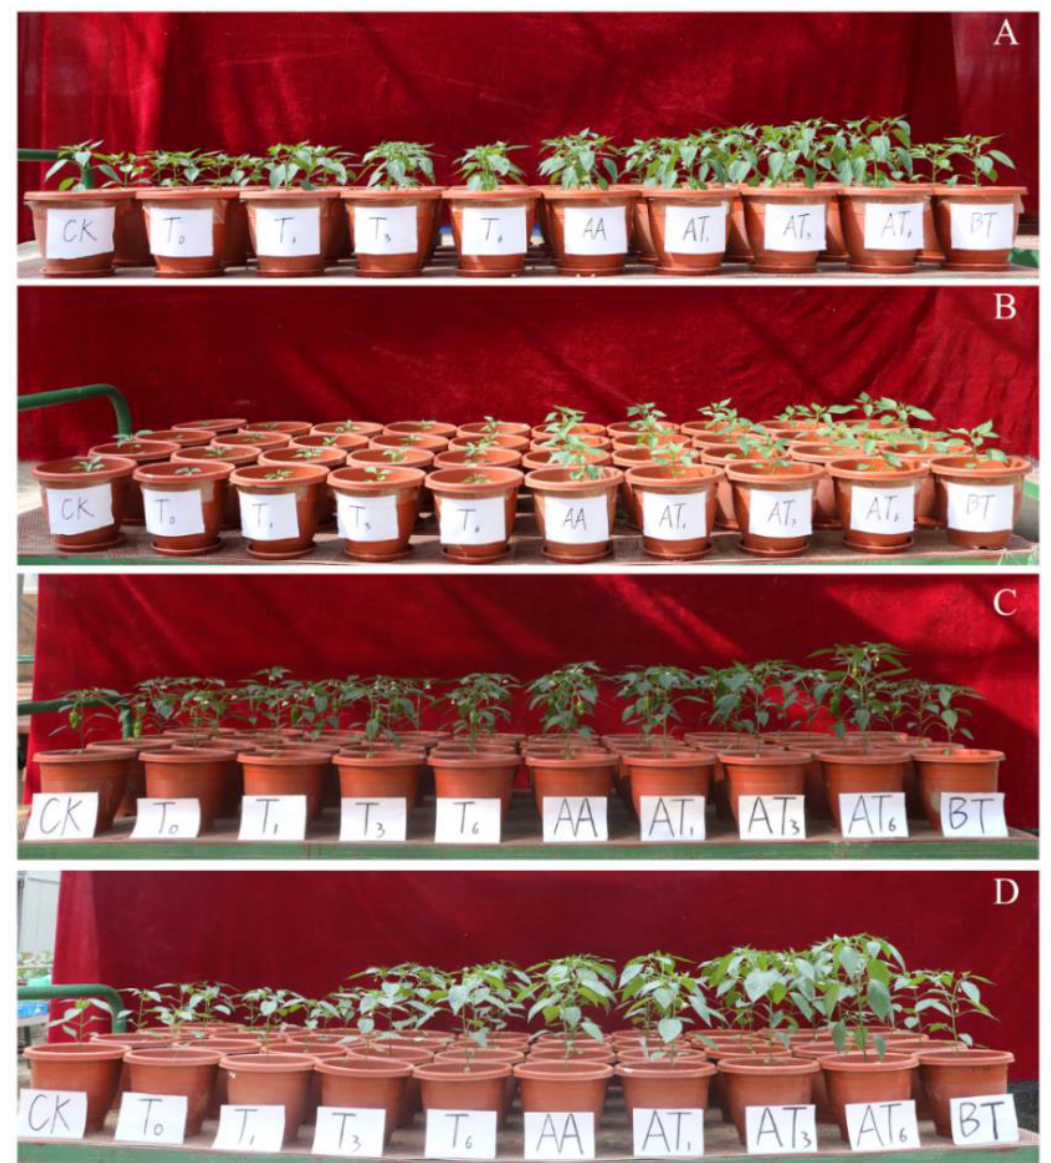
Figure 2. The pepper growth promotion in different treatments in sandy soil and mountain soil during two growth seasons. ( A ) The pot experiment results in sandy soil during the first season (FS); ( B ) the pot experiment results in mountain soil during the FS; C) the pot experiment results in sandy soil during the second season (SS); D) the pot experiment results in mountain soil during the SS; the treatments of the greenhouse pot experiment were as follows: T0: adding 0.01% (w/w, dw) chopped rice straw with the size of 1–2 mm; T1: 0.01% (w/w, dw) solid fermentation products; T3: 0.03% (w/w, dw) solid fermentation products; T6: 0.06% (w/w, dw) solid fermentation products; AA: 20% (v/w, dw) amino acid solution; AT1: 20% (v/w, dw) amino acid solution and 1% (w/w, dw) BOF (w/w, dw); AT3: 20% (v/w, dw) amino acid solution and 3% (w/w, dw) BOF; AT6: 20% (v/w, dw) amino acid solution and 6% (w/w, dw) BOF; BT: Bacillus amyloliquefaciens SQR-9-based BOF (stored in our lab); CK: chemical fertilizer.